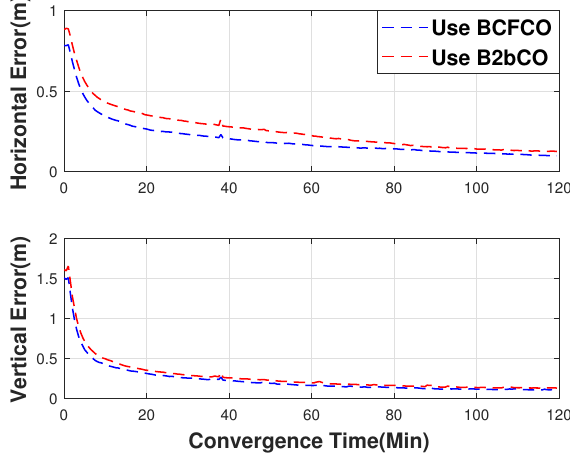
Figure 7. Convergence performance of BCFCO and